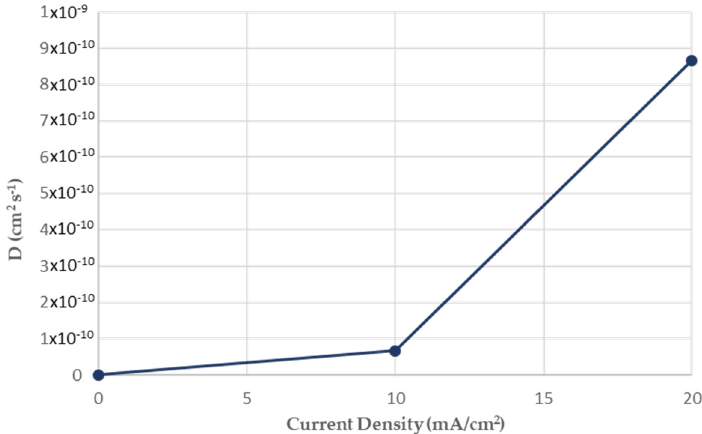
Figure 7. E ff ect of the applied current density (10 mA / cm 2 and 20 mA / cm 2 ) on the di ff usion coe ffi cient of hydrogen cations into the ferritic-bainitic microstructure of X65 pipeline steel.